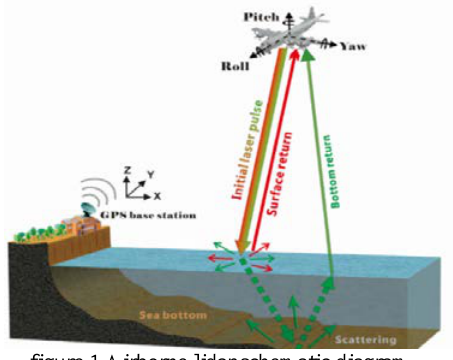
figure 1 Airborne lidar schematic